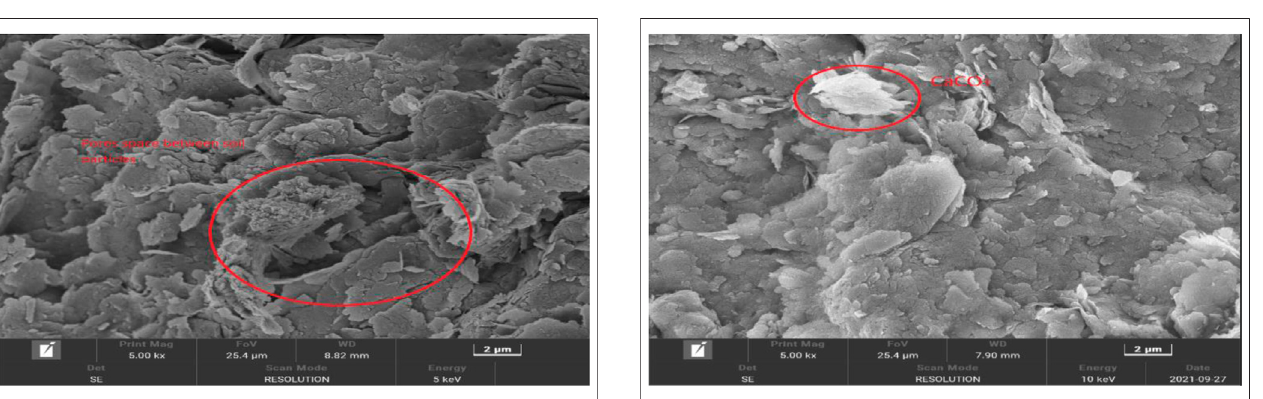
FIGURE 2 | SEM imaging of unimproved expansive soil. FIGURE 3 | SEM imaging of improved expansive